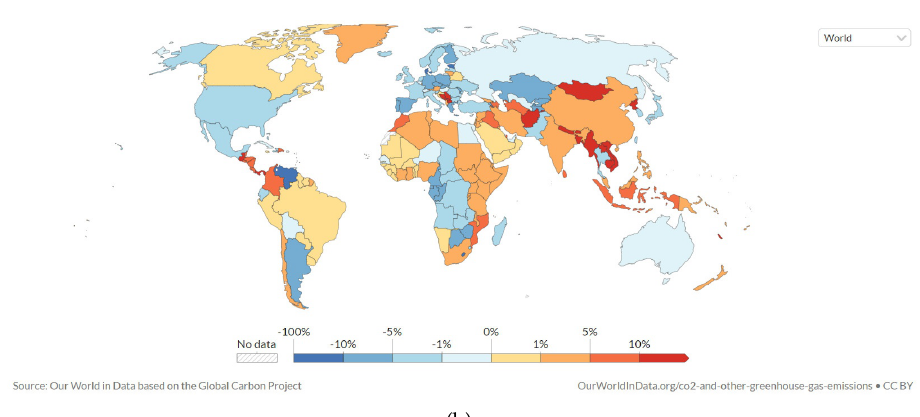
Figure 2. Annual percentage change in CO 2 emissions: ( a ) 2020, ( b ) 2021.